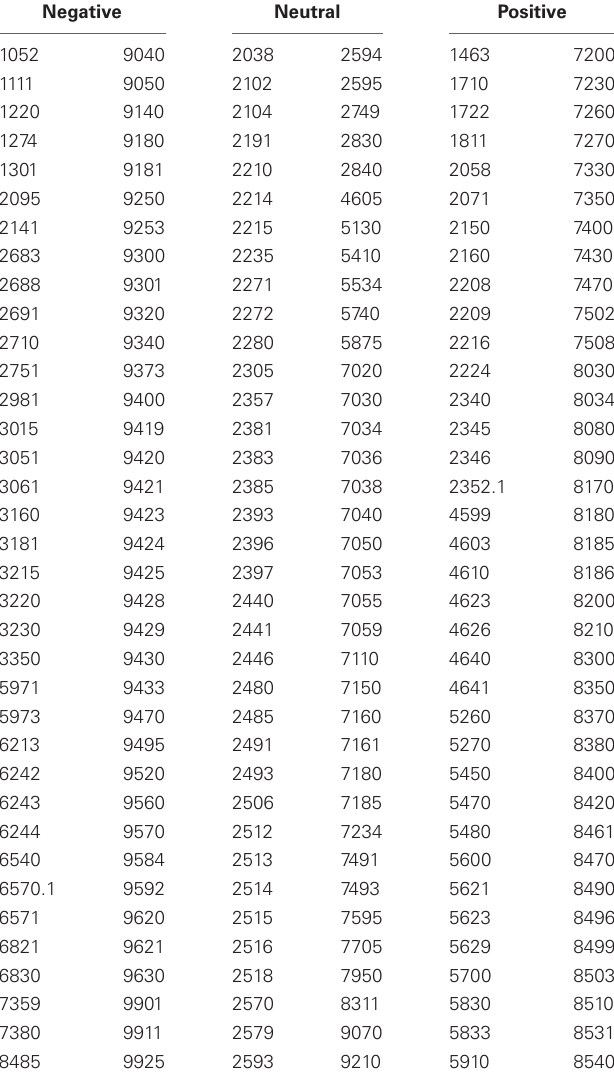
Table 1 | Reference numbers to images taken from the International Affective Picture System (IAPS; Lang et al., 2005).